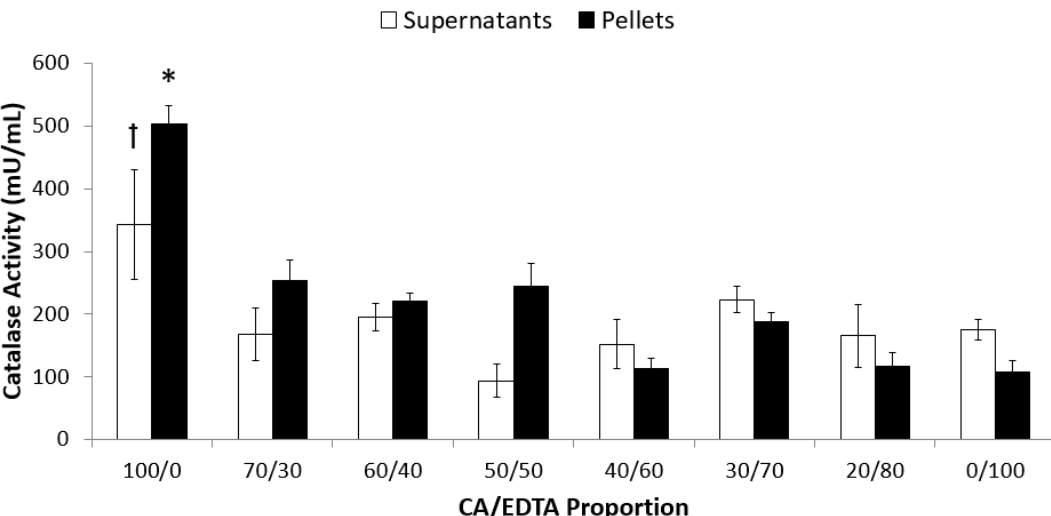
Figure 1. CeNPs stabilized with only CA displayed the highest catalase-mimetic activity. Catalase- mimetic activity of 60 μ M of supernatant or pellet fraction of each CeNP formulation was assessed using a commercial assay kit. Data are presented as mean ± SEM of n = 4–10 separate experiments in which each formulation was assayed in triplicate. Statistical significance was determined using a two- way ANOVA and post-hoc comparisons were made using the Bonferroni correction for multiple, preplanned comparisons. Symbols indicate p < 0.05 compared to all other supernatant ( ꝉ ) or pellet (*)